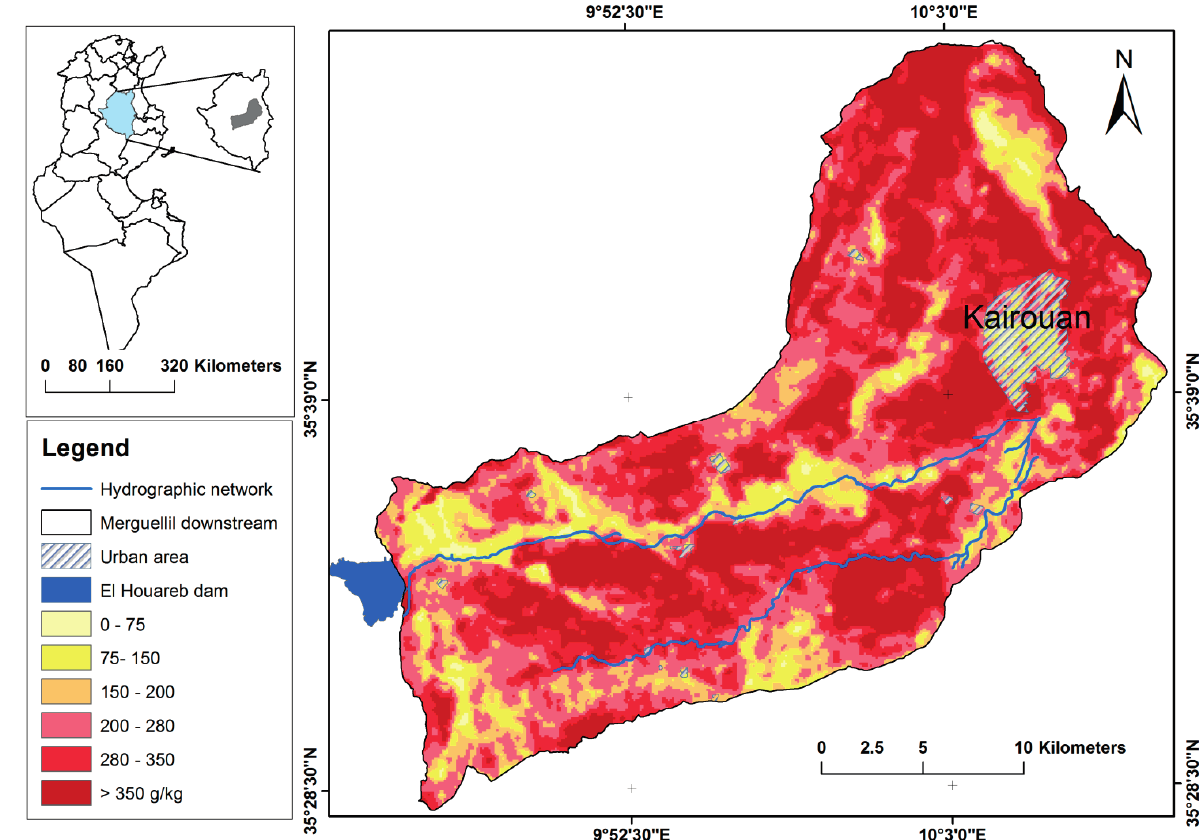
Figure 7. Clay content map at 100 m spatial resolution produced by combining four Landsat TM images: 16 July 2009, 1 August 2009, 2 September 2009 and 18 September 2009. (Blue line) corresponds to hydrographic